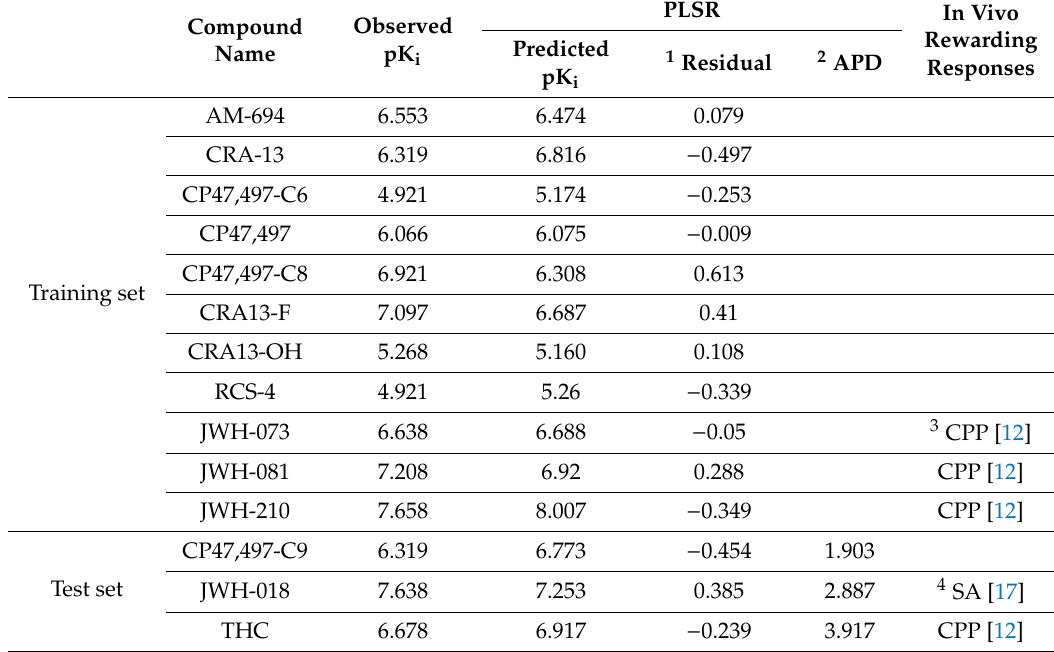
Table 2. Cannabinoid receptor 1-binding a ffi nity (pKi) of synthetic cannabinoids predicted by the partial least squares (PLSR) quantitative structure–activity relationship